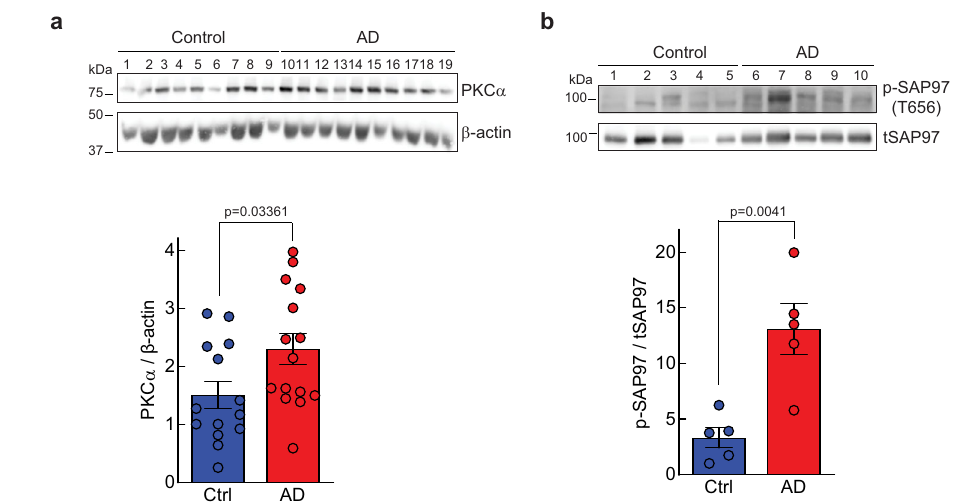
Fig. 7 | PKC α levels and phosphorylation of SAP97 is increased in the frontal cortex of patients with Alzheimer ’ s disease. a Western blot of lysates of frontal cortexobtainedfromninebrains(lanes1 – 4,females;lanes5 – 9,males)fromcontrol patientsandninebrains(lanes10 – 14,females;lanes15 – 19,males)fromADpatients. Westernblotswereprobed withantibodiesspeci fi ctototalPKC α (top)and β -actin (bottom) as loading control. Graph depicts the quanti fi cation of the data in the westernblot,includinganadditional5samplesofeachcondition. b Westernblotof lysates of frontal cortex obtained from fi ve brains (lanes 1 – 2, males; lanes 3 – 5, females) from control patients and fi ve brains (lanes 6 – 7, males; lanes 8 – 10,